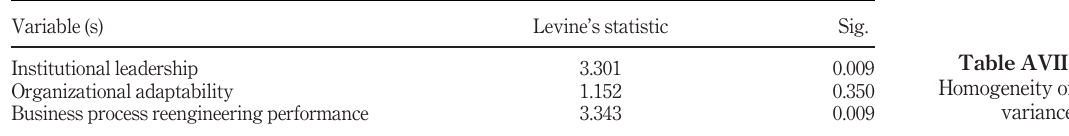
Table AVII. Homogeneity of